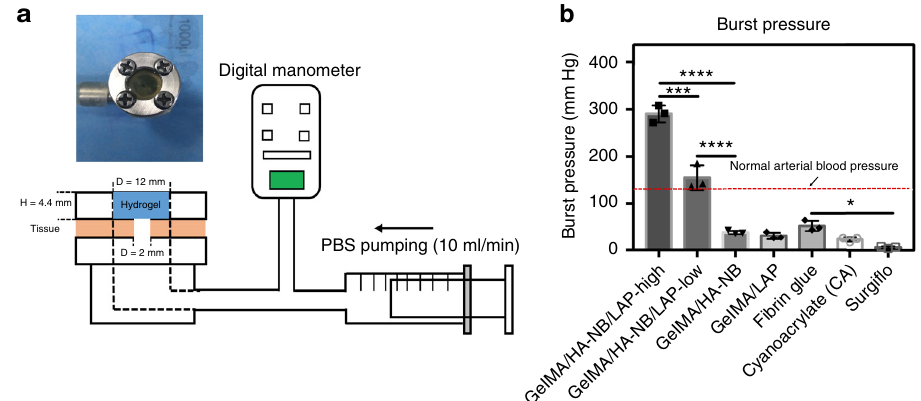
Fig. 2 Burst pressure of different hydrogels and surgical hemostatic glues. a Schematic illustration of the experimental procedure and pressure chamber for burst adhesion testing using a punctured, then sealed porcine sausage skin membrane. b The observed burst pressure of different hydrogels and the commercially available Cyanoacrylate and Fibrin Glue and Surgi fl o TM , a gelatin-based absorbable porcine gelatin paste used for hemostasis (error bars, mean ± SD; * p < 0.05, ** p < 0.01, *** p < 0.001, **** p < 0.0001, one-way analysis of variance (ANOVA), Tukey ’ s post hoc test) ( n = 3 per group) Source data are available in the Source Data fi